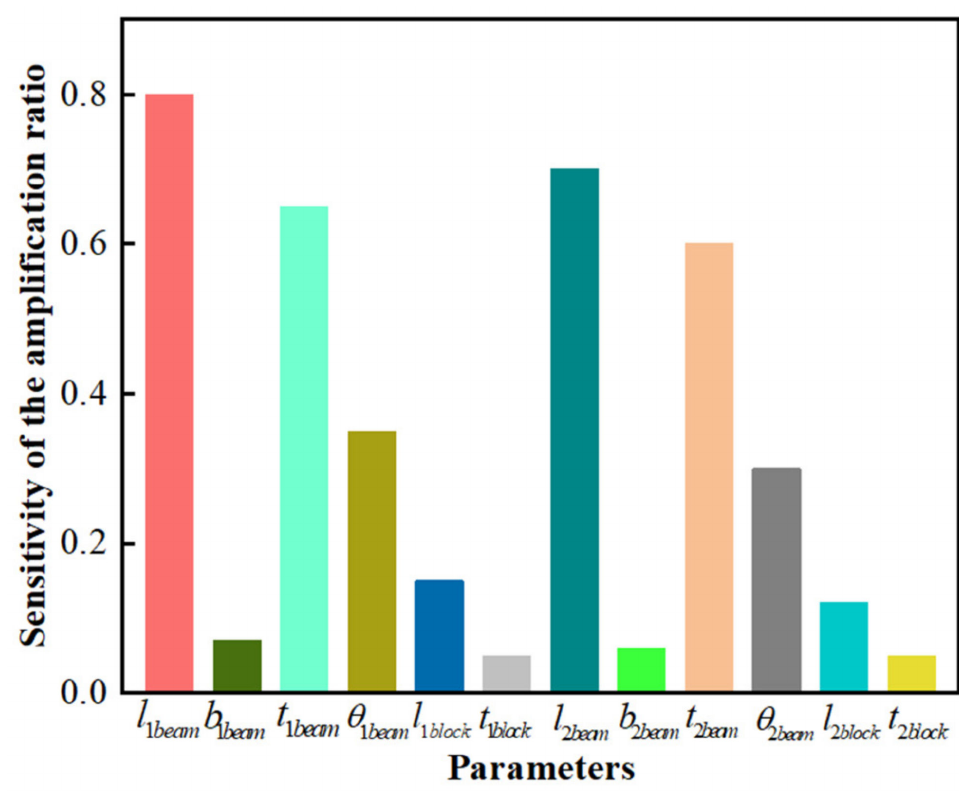
Figure 10. Sensitivity of optimization parameters to the amplification ratio of a double-stage rhombus amplification mechanism. Table 6. Range of dimensional parameters and optimization results of the double-stage rhombus amplification